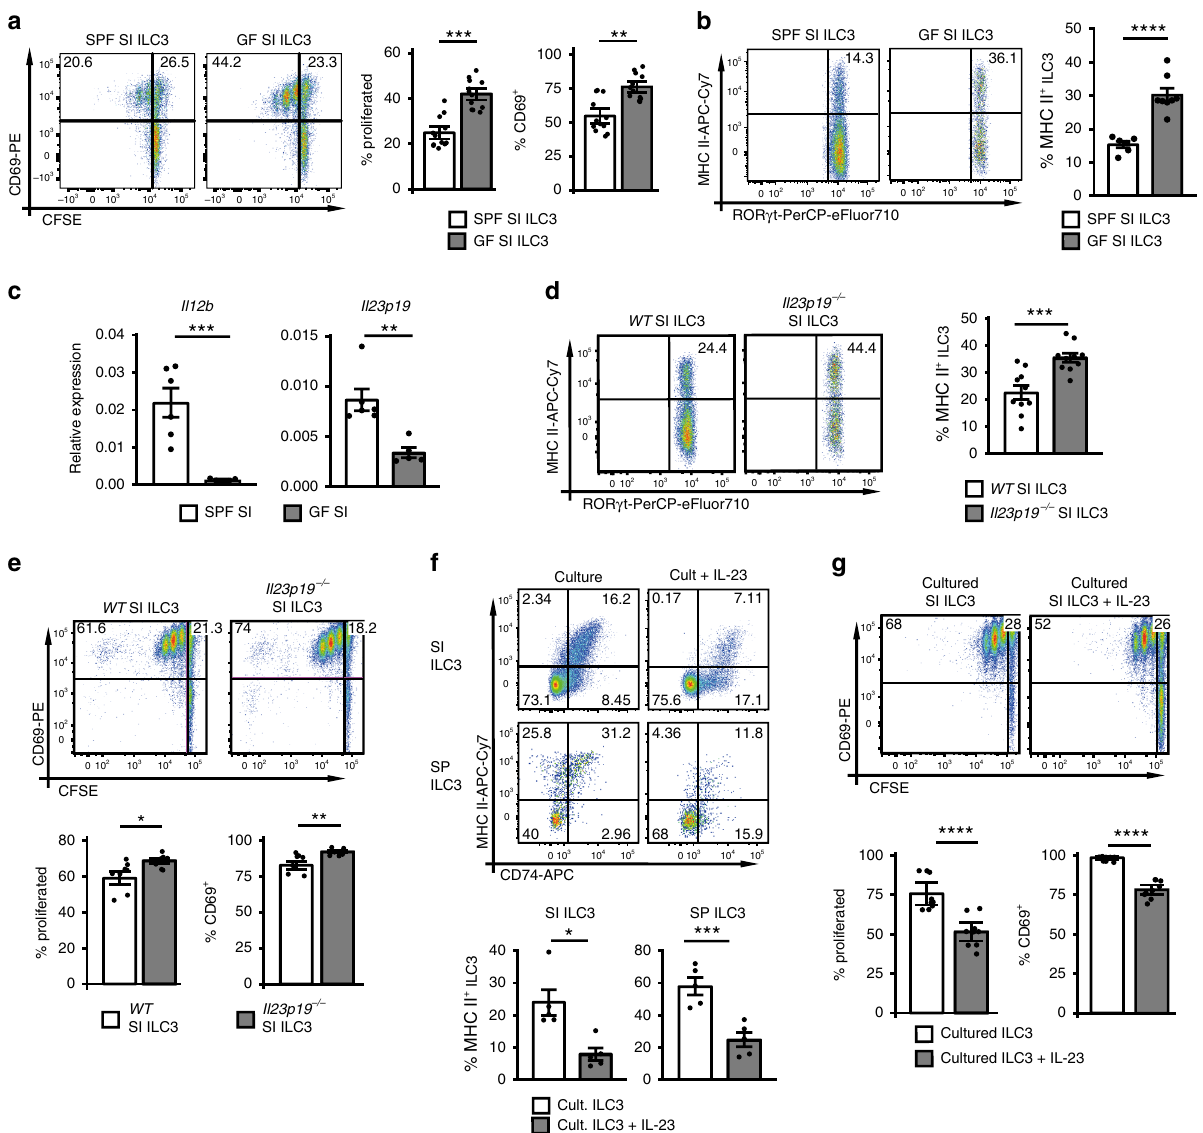
Fig. 5 The microbiota and IL-23 negatively regulate Ag presentation by ILC3s. a CFSE-labeled OT-II tg CD4 + T cells were stimulated with 1 × 10 4 SPF or GF ILC3s ( Rag − / − background) in the presence of Ova peptide. n = 12 distinct samples of three independent experiments. ILC3s were sorted as depicted in Supplementary Fig. 2a. b MHC II expression of SI ILC3s from SPF ( n = 6 mice) and GF ( n = 8 mice) mice on Rag − / − background. NCR − ILC3s were gated as shown in Fig. 1. Two independent experiments. c Relative expression of Il12b and Il23p19 in the terminal ileum of SPF ( n = 6 mice) and GF ( n = 5 mice) mice on Rag − / − background analyzed by qRT PCR. Two independent experiments. d MHC II expression of SI ILC3s from WT and Il23p19 − / − mice ( n = 10 mice). NCR − ILC3s were gated as shown in Fig. 1. Five independent experiments. e Naive CFSE-labeled OT-II tg CD4 + T cells were cultured either with 5 × 10 4 SI ILC3s of WT ( n = 8 distinct samples) or Il23p19 − / − ( n = 10 distinct samples) mice in the presence of Ova peptide. Four independent experiments.